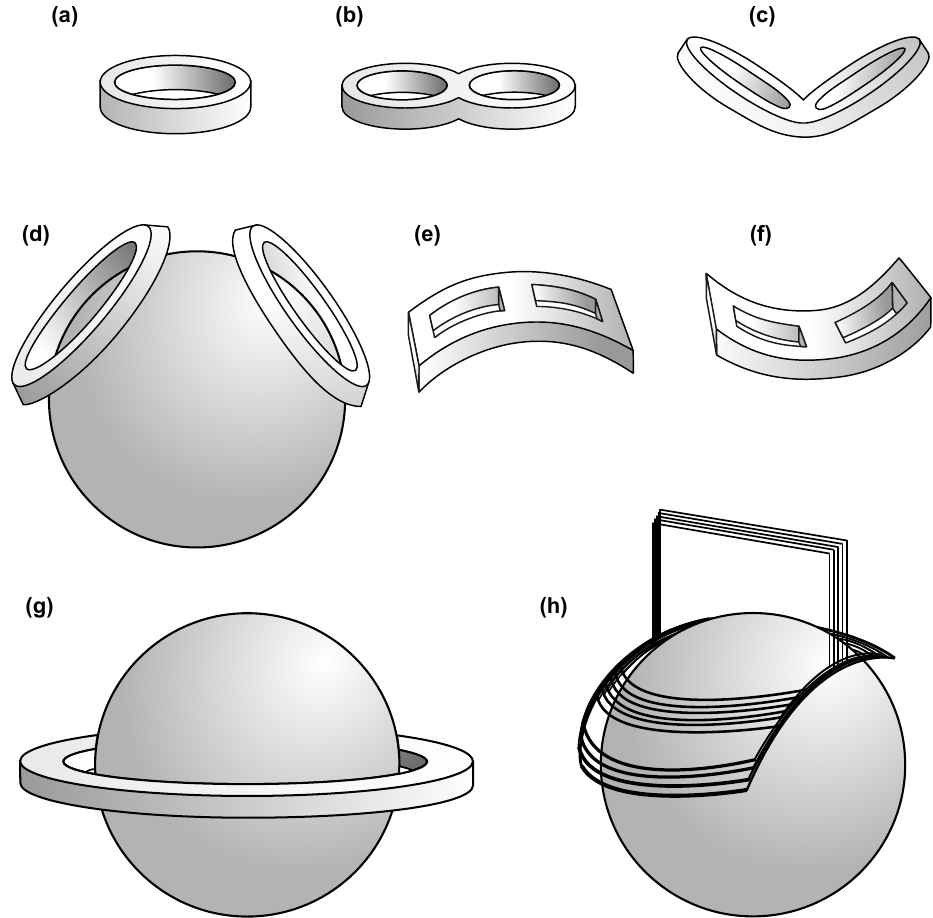
Figure 5. Most used TMS coils. ( a ) Circular coil, ( b ) Figure-of-Eight (FoE) coil, ( c ) Butterfly (V-shape) coil, ( d ) Cone (double circular) coil, ( e ) Downward-Bending U-shape (DBU) coil, ( f ) Upward-Bending U-shape (UBU) coil, ( g ) Halo coil, and ( h ) Hesed coil